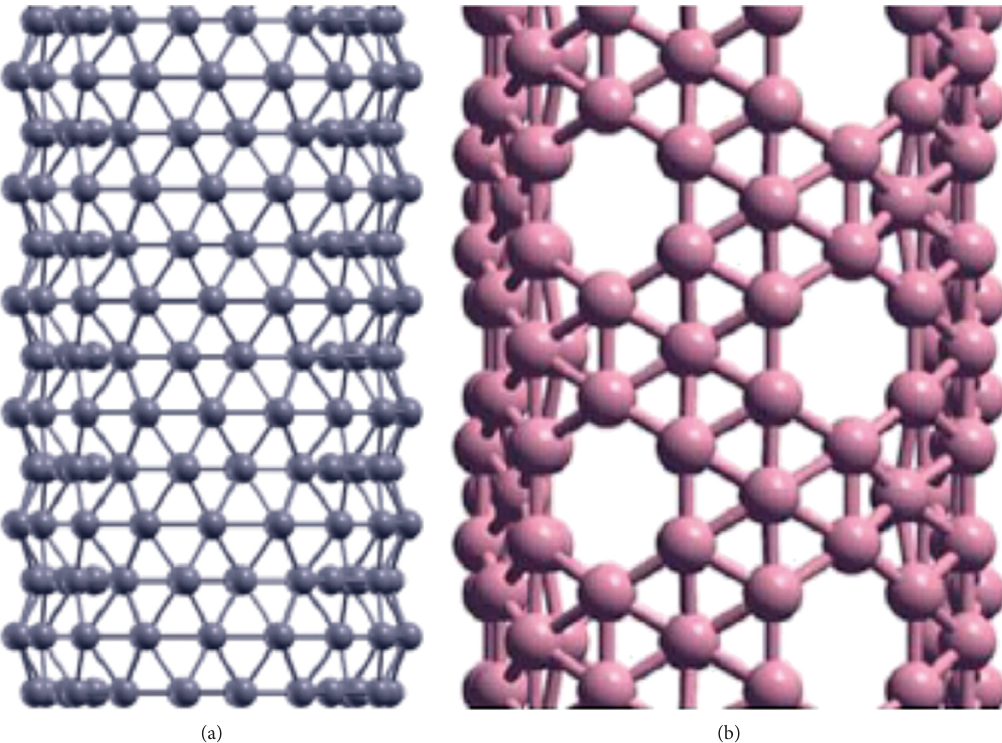
Figure 1: (a) A 3D perception of boron triangular nanotube. (b) A 3D perception of boron- α